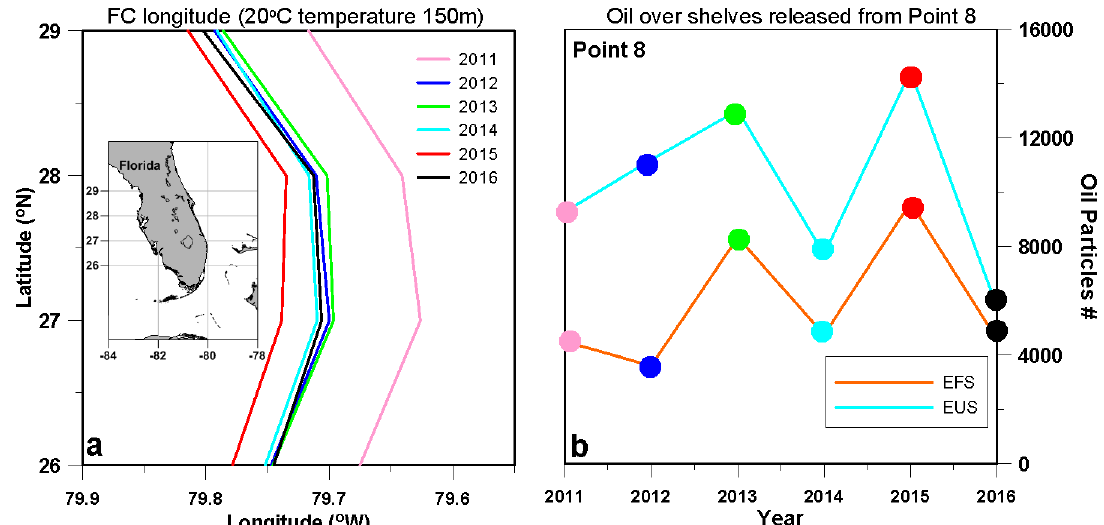
Figure 14. ( a ) Florida Current (FC) longitude, as derived from the 20 °C temperature contour line at 150 m along 26, 27, 28, and 29° N in the Atlantic Ocean (map in the insert) and averaged for each year during the 2011–2016 period. ( b ) Annual number of oil elements released at Point 8 (Figure 1b) detected inside the Eastern Florida Shelf (EFS; orange line) and Eastern US (EUS; blue line). The dot color in ( b ) represents the respective year presented in ( a ).